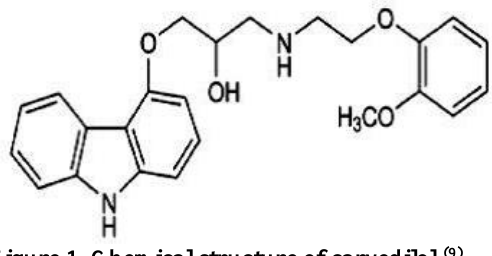
Figure 1. Chemical structure of carvedilol (9) It is a powder with white to off white color with melting point (m.p.) 114-115 ℃. It is practically insoluble in water, soluble in methylene